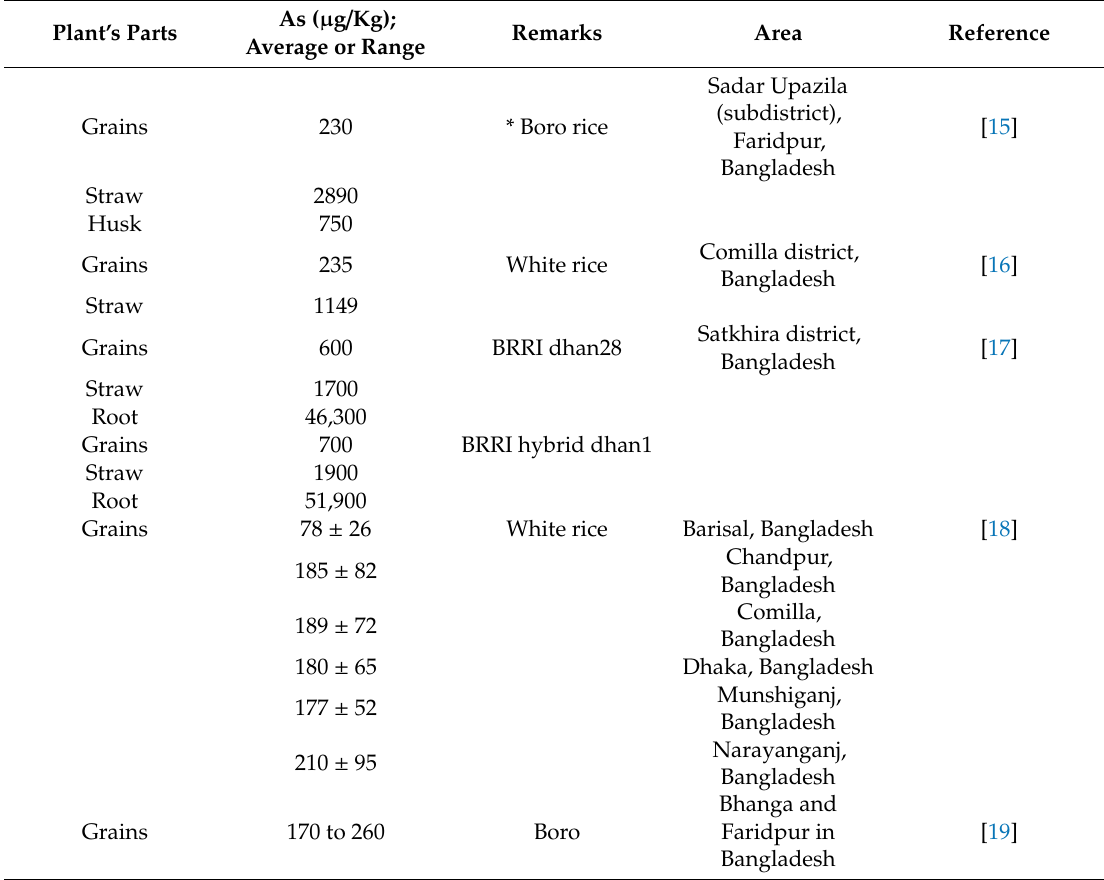
Table 1. Arsenic found in rice plants around the